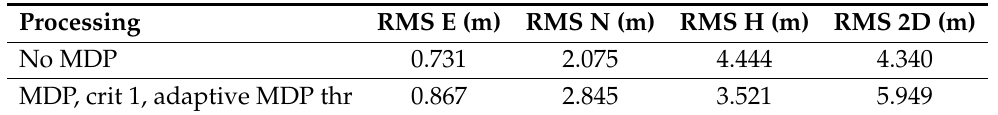
Table 7. RMS obtained for criterion 1, adaptive MDP threshold.